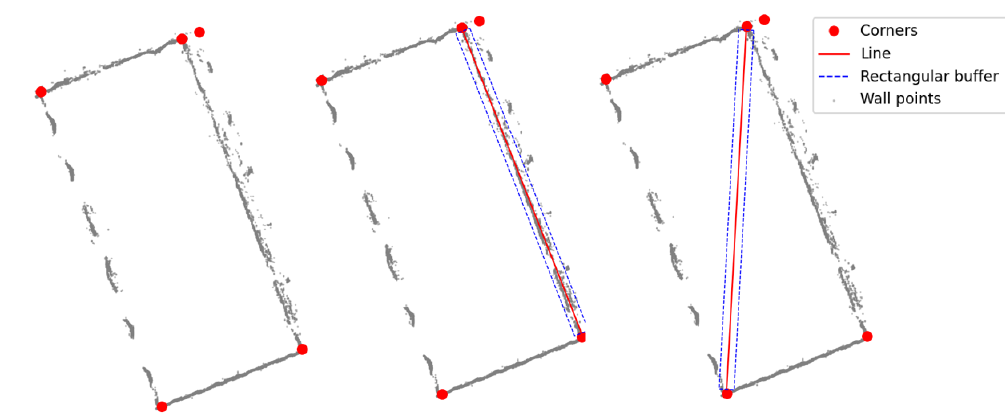
Figure 10 . Intersection of the lines in every combination (red points) and the finding real edges by checking the density of the points in a buffer